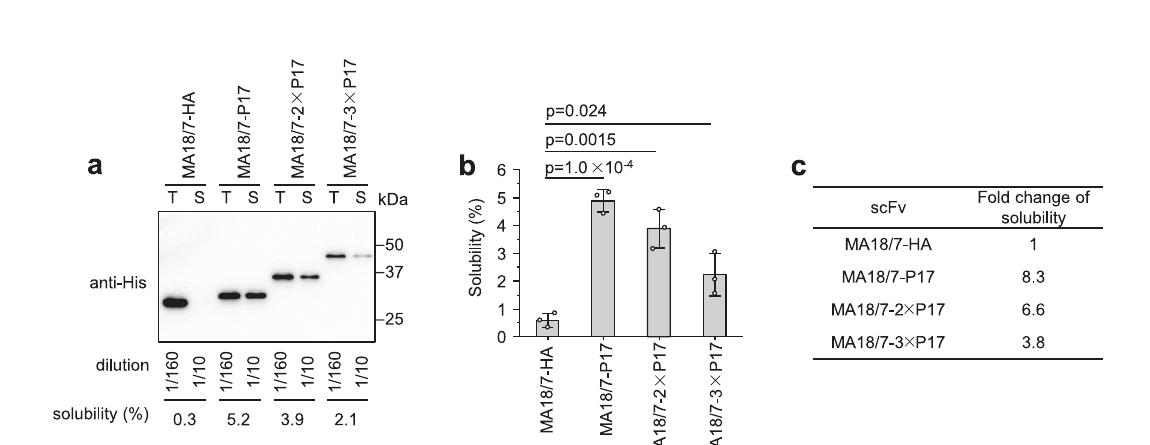
Fig. 3 | A C-terminal P17 tag increased scFv solubility in SHuf fl e T7 cells more ef fi ciently than N- or C-terminal MBP and N-terminal GST. a Determination of solubility of each G12-scFv fusion protein with HA and P17 tag attached at C-ter- minus,MBPtagatNorC-terminus,orGSTtagatNterminusbywesternblotting.T, total protein; S, soluble protein. b Solubility of G12-scFv fusion proteins was